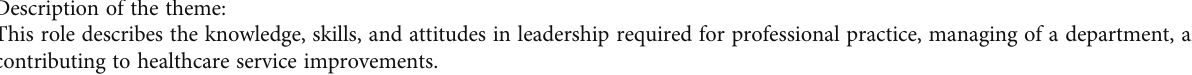
Table 6: Theme 5: role as a leader and a